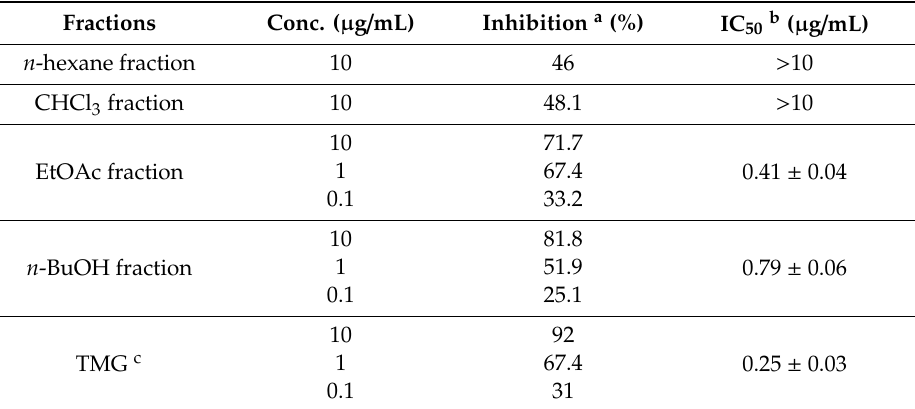
Table 4. IC 50 values of the fractions of G.